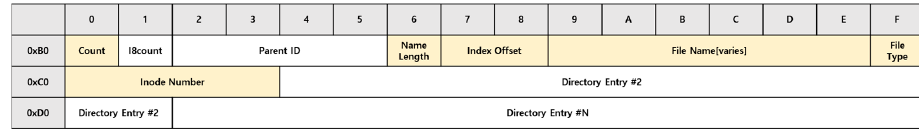
Figure 8. Directory entries structure of XFS file system. Figure 7. Inode core structure of XFS file system.